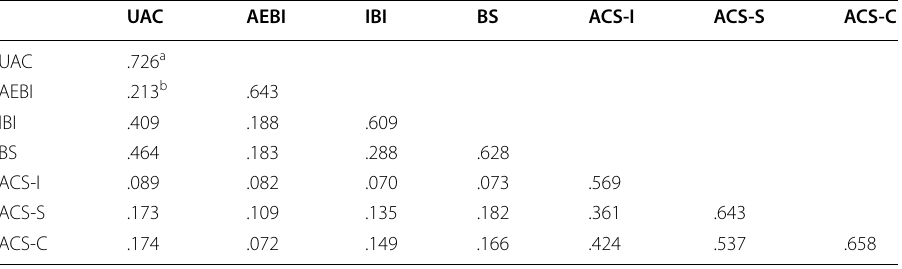
Table 5 Inter-construct correlation